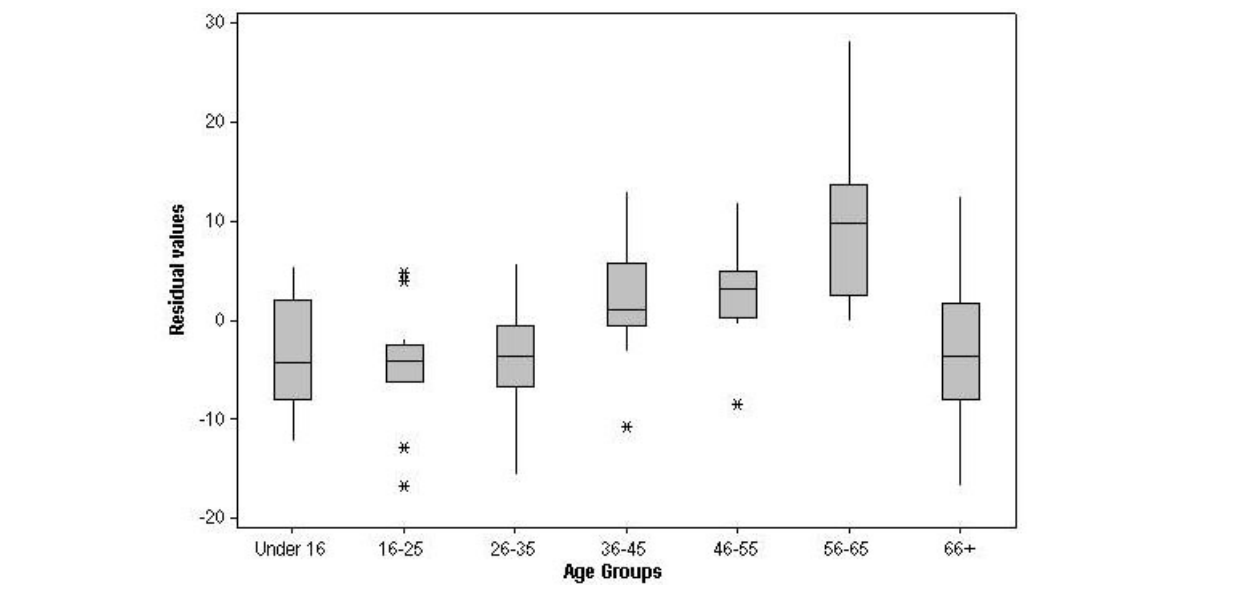
Fig. 3 . Residuals of age groups for the 50 th percentiles of distance